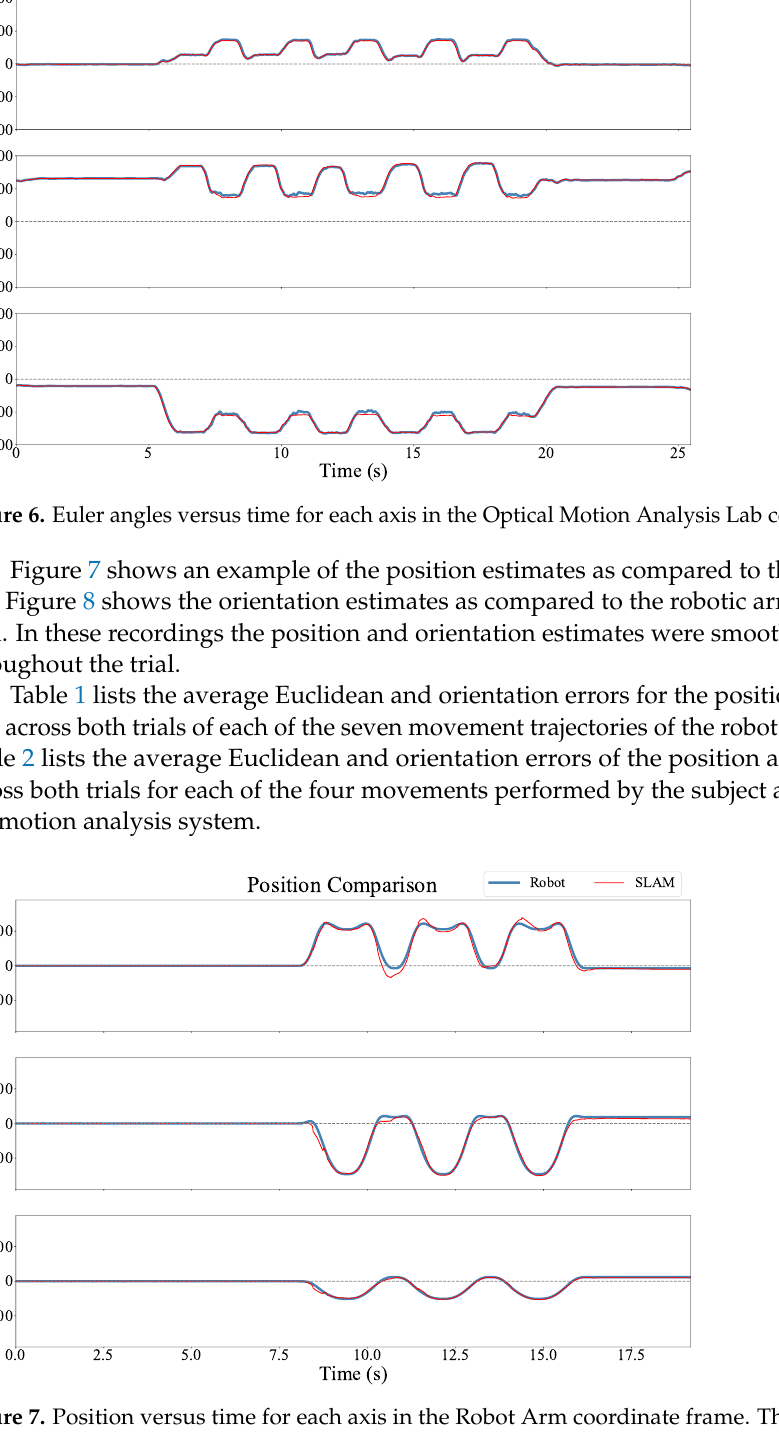
Figure 7. Position versus time for each axis in the Robot Arm coordinate frame. The two estimates were in strong agreement, but the SLAM estimate included